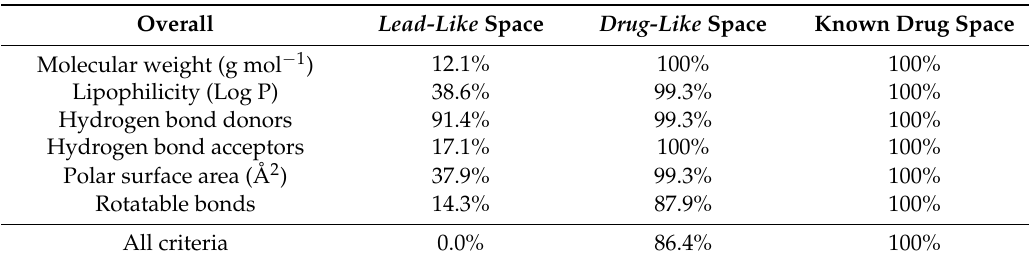
Table 4. All classical lignans and neolignans (not CLCs or flavonolignans) studied within the defined chemical spaces.